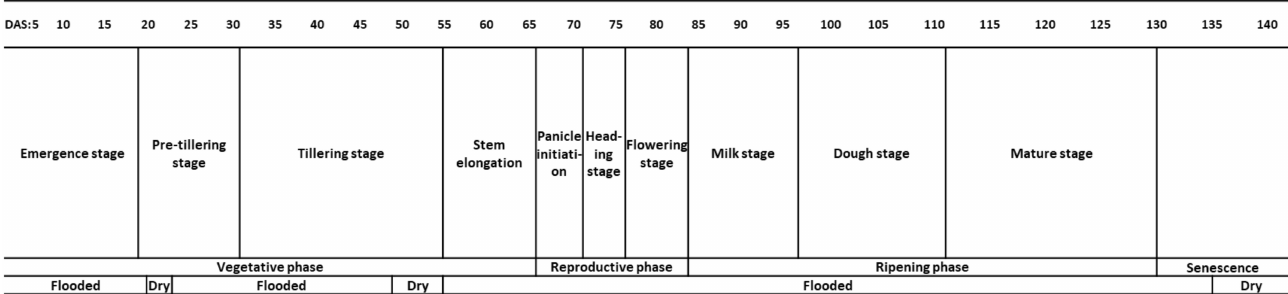
Figure 2. Timing of the main phenological stages of rice in Valencia until harvest (DAS: Days after Sowing) and the last row the water